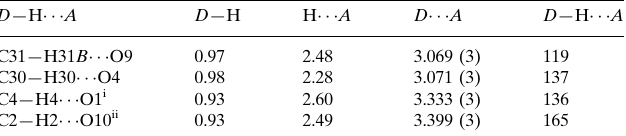
Hydrogen-bond geometry (A˚ , (cid:1)